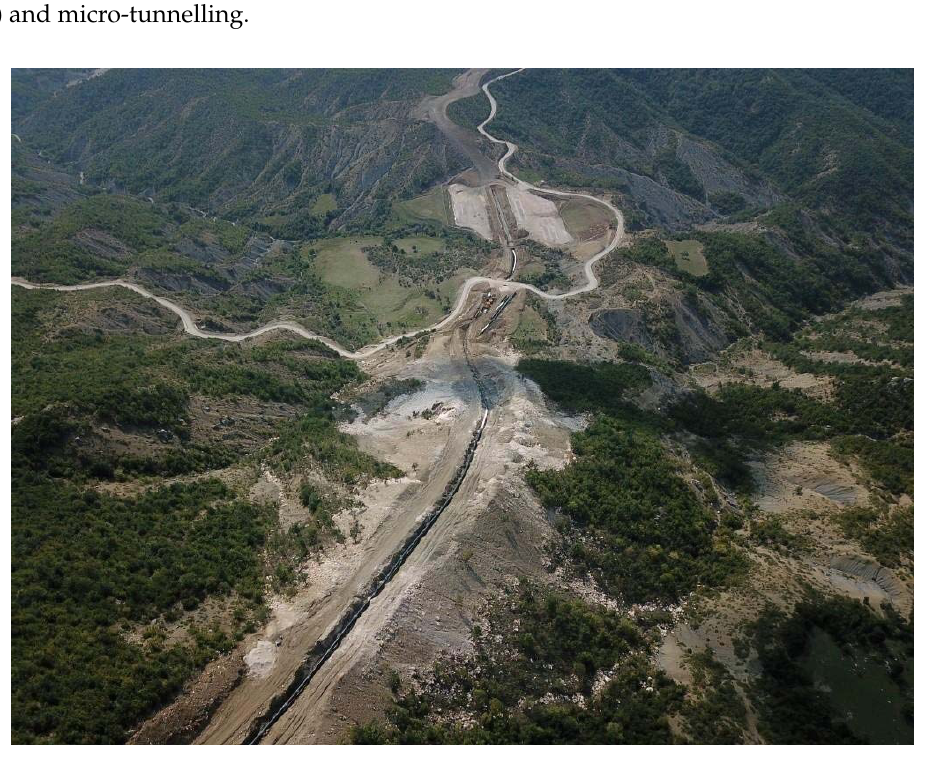
Figure 3. Right of Way (RoW) for major gas pipelines is a strip of land, usually between 18 and 36 m wide, containing one or more pipelines, used as access for inspection, maintenance, testing or emergency.